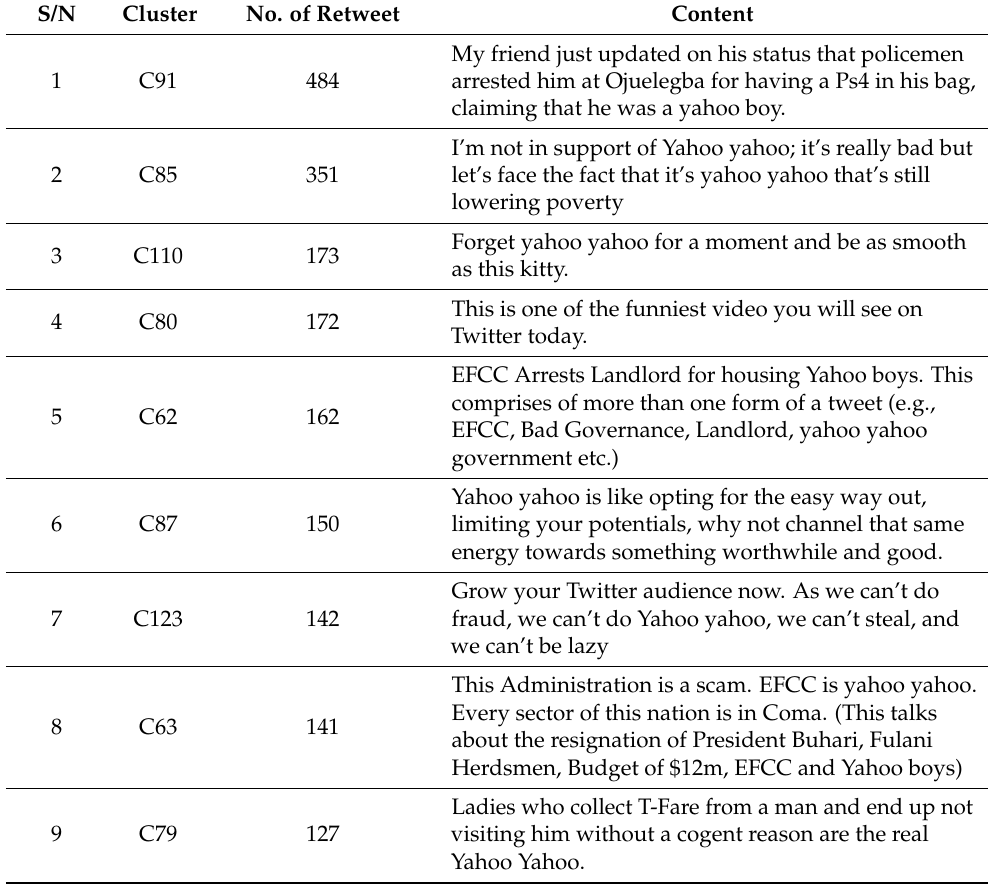
Table 3. Top twenty tweets showing the cluster, number of retweets, and content. S/N Cluster No. of Retweet